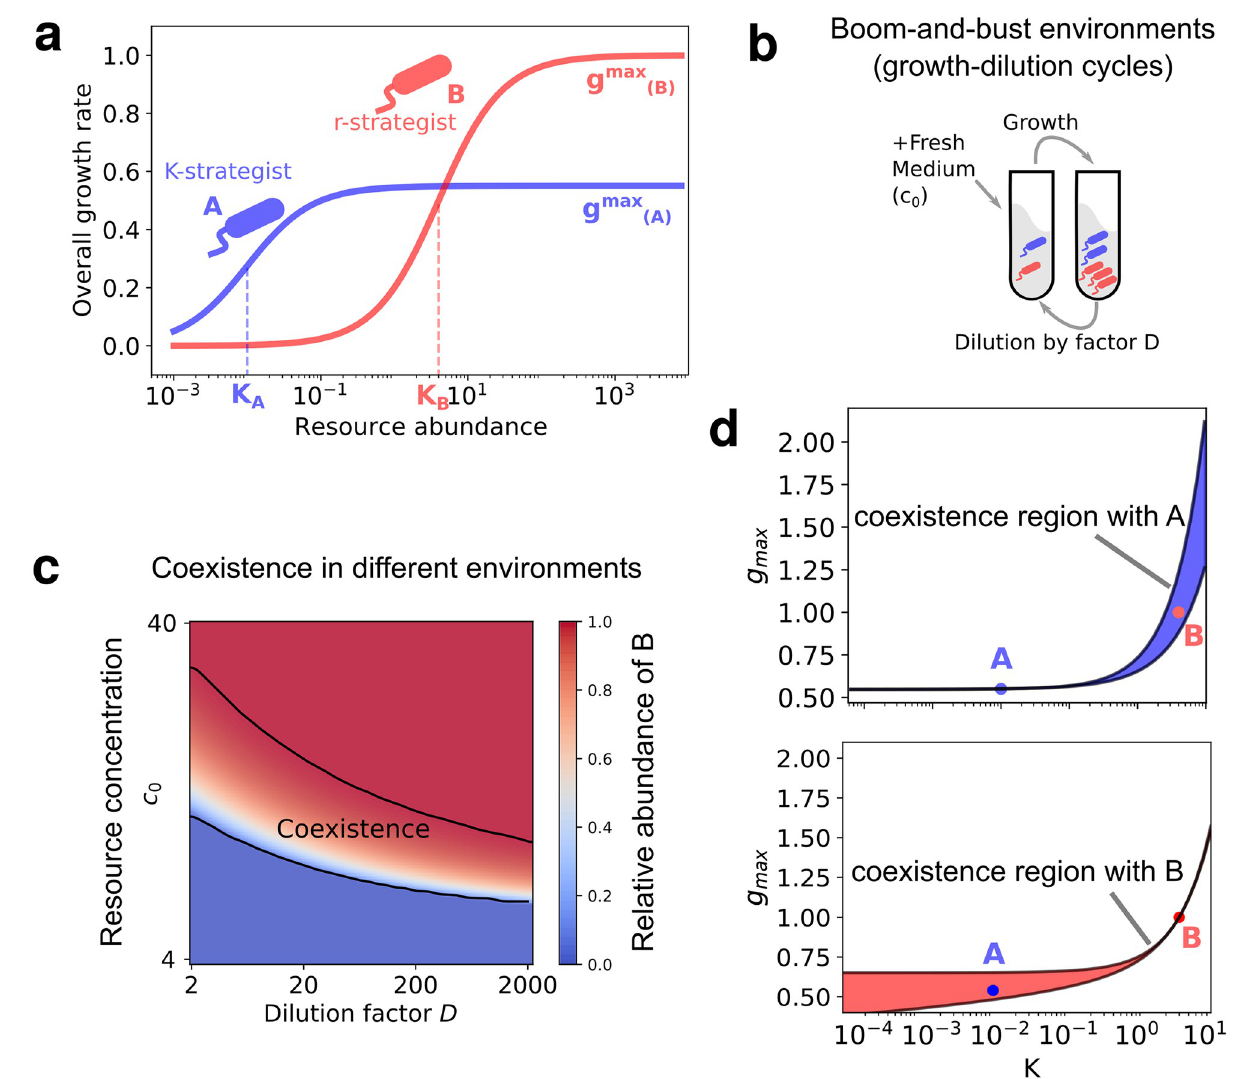
Fig 1. Coexistence of two strains in a boom and bust environment supplied with a single limiting resource. (a) Strains A and B follow Monod’s law of growth. Strain A is a K -strategist with a lower maximum growth rate g max and substrate affinity( K ) compared with strain B, which is an r -strategist. (b) Schematic of the serial dilution experiment. At the end of each cycle, we dilute the population by a factor D , and supply fresh medium with resource concentration c 0 (see Methods). (c) Feasible environmental parameters for two strains with given growth rates. Each point on the heatmap defines an environment, characterized by c 0 and D , and the color of each cell represents the relative abundance of strain B at steady state. Black lines show the range of environments where both strains, A and B, coexist. (d) Coexistence region in terms of growth parameters of strain B for a fixed environment ( D = 10, c 0 = 10) and fixed strain A . The blue region represents the range of growth parameters of B (red dot) where it can coexist with strain A (blue dot) in a fixed environment. Black solid lines are theoretical boundaries of the region.